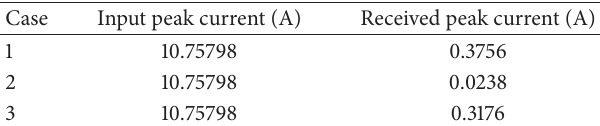
Figure 19: 2D gain of the CRA for the third iteration at 8.5 GHz. Table 3: Received currents.